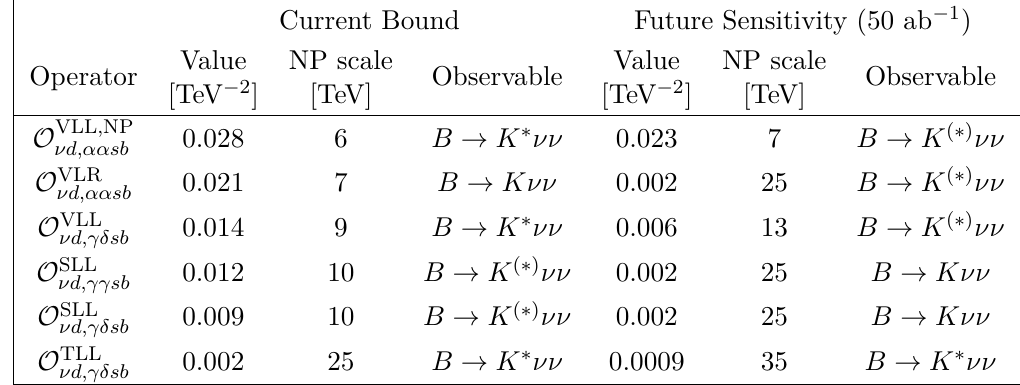
Table 2 . Most competitive bounds imposed on the absolute value of the respective Wilson coef- ficients if only one of them gets (sizeable) contributions from new physics at a time, both for the current situation and for the projections for the 50 ab − 1 Belle-II data set under the assumption of a confirmation of the SM predictions. Here, α ∈ (1 , 2 , 3) and γ and δ arbitrary, but γ 6 = δ (only in the case of O VLL , γ and δ may be equal if larger than 3), and neutrino masses are set to zero νd,γδsb both for active and sterile states. Generally, the most conservative constraint is provided, with the possibility of interference with the SM taken into account. We also provide rough estimates for the corresponding new-physics scale and the observable from which the respective bound arises. If B → K ( ∗ ) νν is indicated, B → Kνν and B → K ∗ νν yield similar